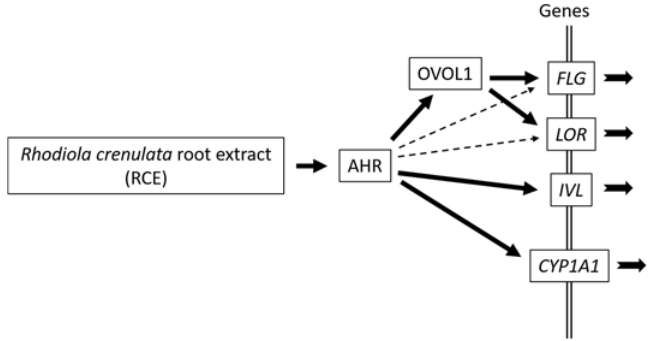
Figure 6. Differential regulation of skin barrier proteins by Rhodiola crenulata root extract. RCE is a potent activator of AHR. Ligation of AHR by RCE upregulates gene and protein expression of CYP1A1 as well as skin barrier proteins such as FLG, LOR, and IVL. The upregulation of CYP1A1 and IVL is directly regulated by AHR. However, the FLG and LOR upregulation is mainly regulated by AHR-OVOL1 signaling (solid arrows). However, there may exist another pathway in which AHR directly upregulates FLG and LOR expression (dotted arrows). Coordinated upregulation of skin barrier proteins by RCE may be beneficial for the management of barrier-disrupted inflammatory skin diseases such as atopic dermatitis.